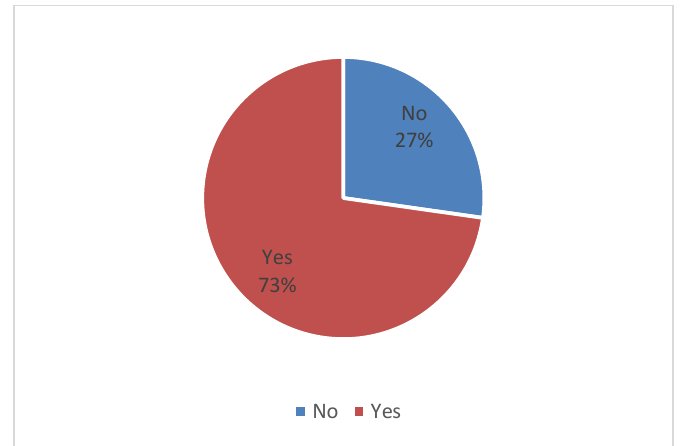
Figure 2: Relationship between the IDP process and community participation; Source : Author